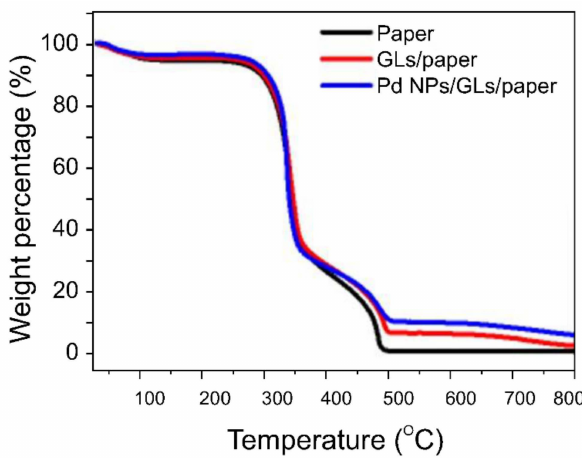
Figure 3. TGA traces used to quantify the number of NPs present in the sensor. The number of Pd NPs located on graphitic layers (GLs) was determined from the residue at approximately 800 ◦ C, at which point sample pyrolysis was